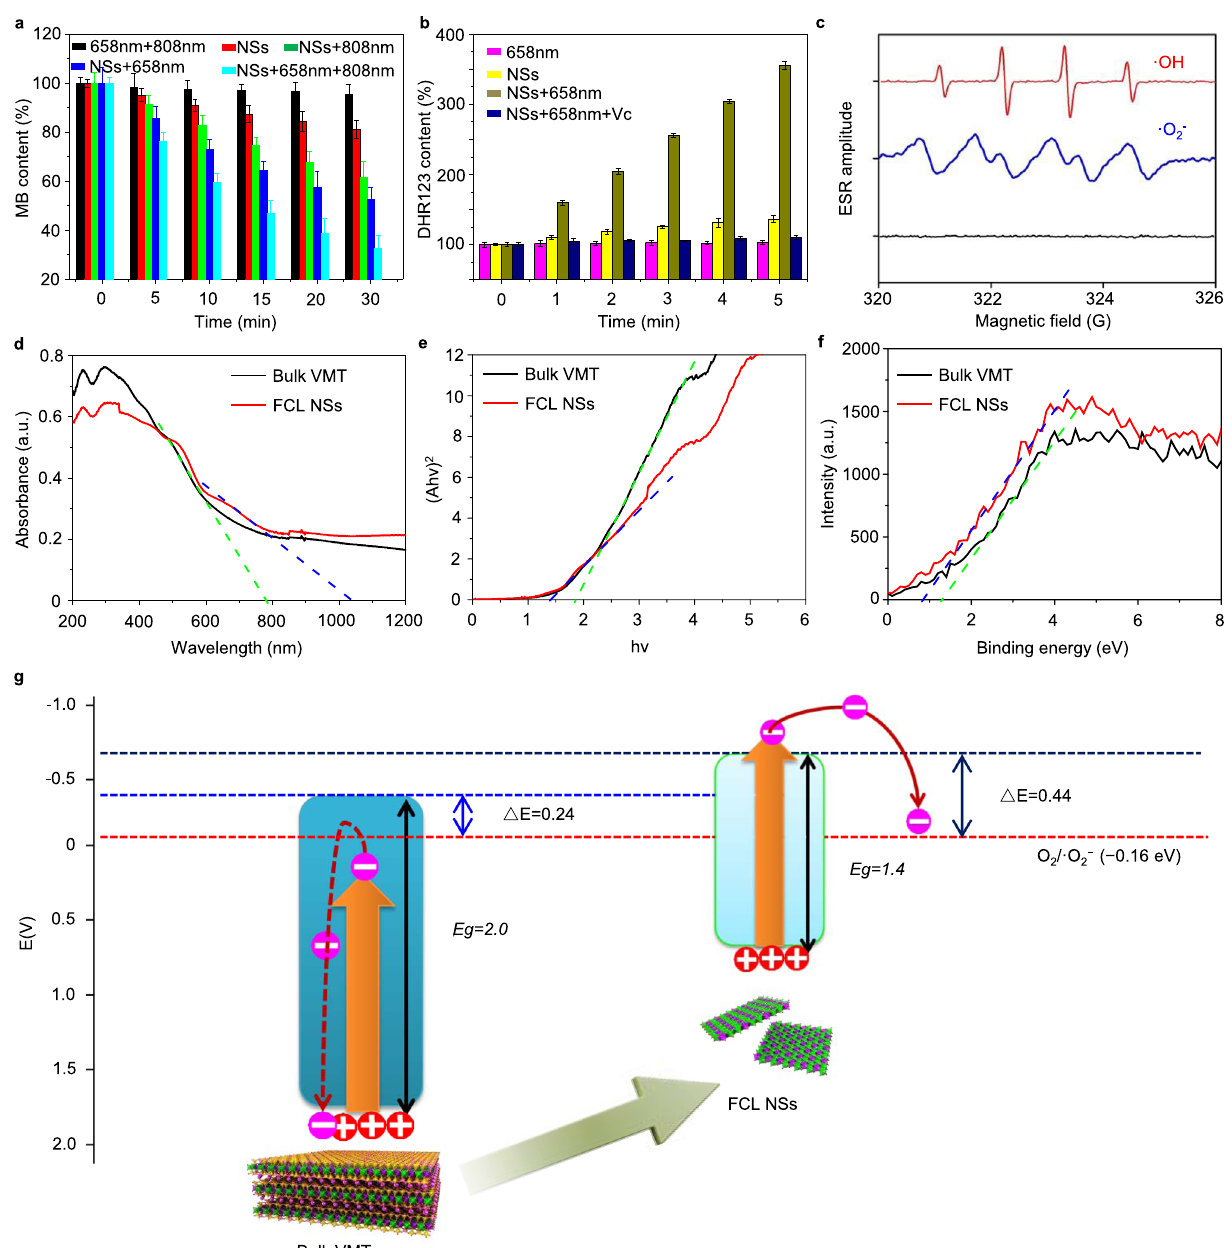
Fig. 4 ROS generation and mechanism of FCL-PEG NSs. a The CDT effect mediated by FCL-PEG NSs using MB as the probe. The data show mean ± s.d., n = 3. b The PDT effect mediated by FCL-PEG NSs using DHR123 as the probe. The data show mean ± s.d., n = 3. c The signal of ROS generated by FCL- PEG NSs in EPR spectra. d All-solid-state UV – vis-NIR absorbance spectra of bulk VMT and FCL-PEG NSs. e The bandgap of bulk VMT and FCL-PEG NSs calculated by Kubelka – Munk equation. f CB of bulk VMT and FCL-PEG NSs. g Schematic illustration of photo-excited electron-hole separation and transfer mechanism of bulk VMT and FCL NSs. CDT chemodynamic therapy, MB methylene blue, PDT photodynamic therapy, DHR123 dihydrorhodamine 123, EPR electron paramagnetic resonance, UV – vis-NIR ultraviolet-visible-near-infrared red, CB conductive